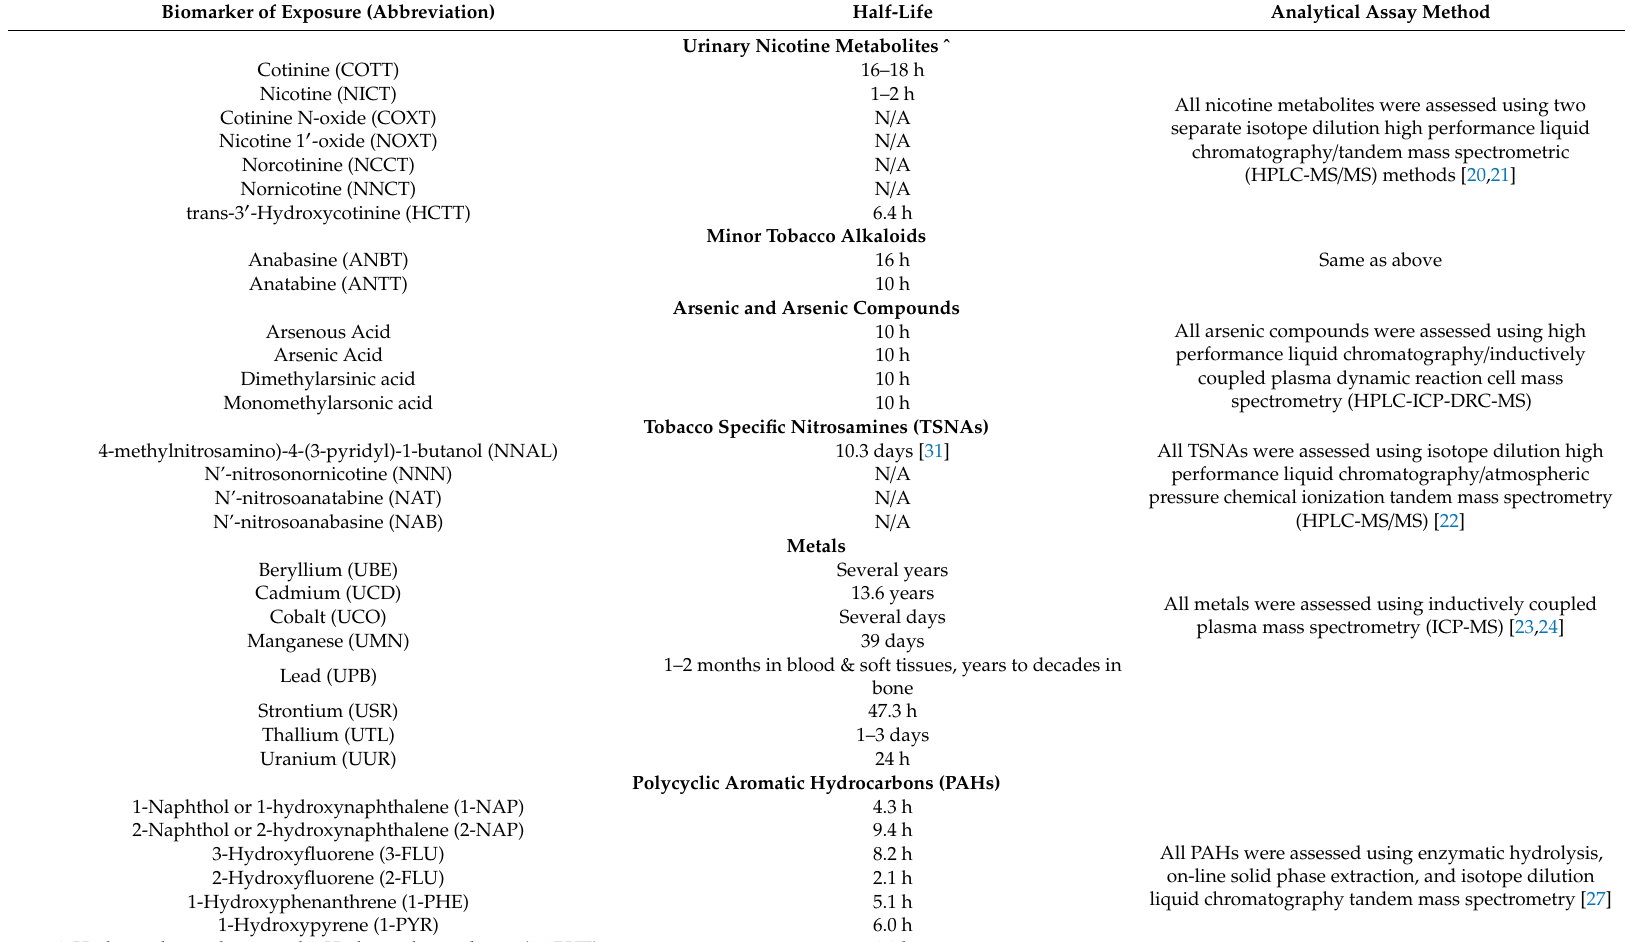
Table 1. Biomarkers of exposure with abbreviations, half-lives, and analytical